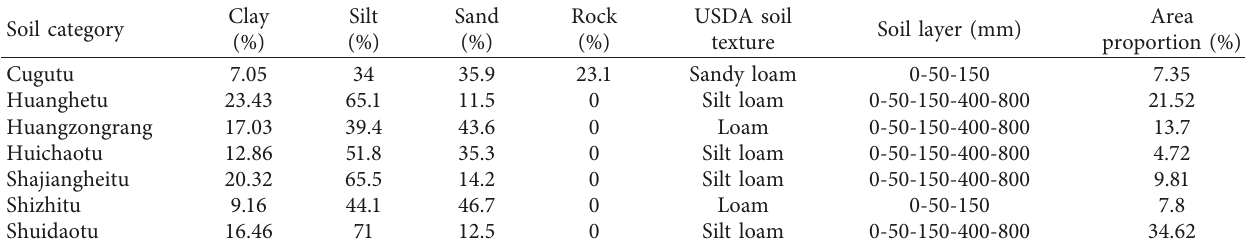
Table 1: Soil classification and its area proportions in the upper Huai River